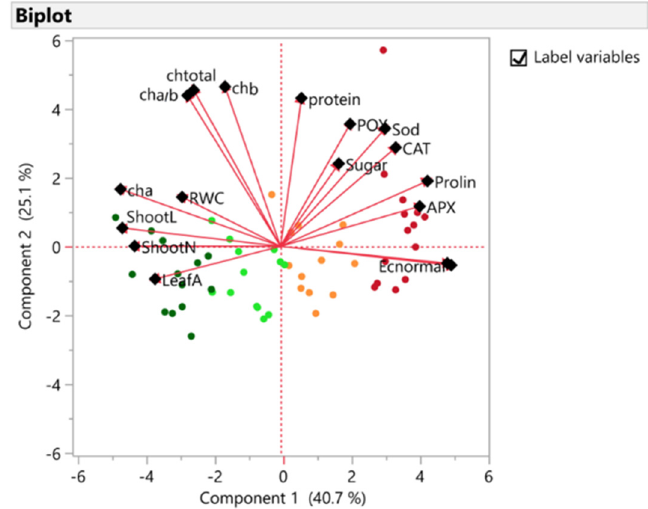
Figure 2. The biplot of PCA results for 17 characteristics of 14 grapevine cultivars under different levels of water stress (green (control), pale green (25% FC), pale red (50% FC), red (75%)).